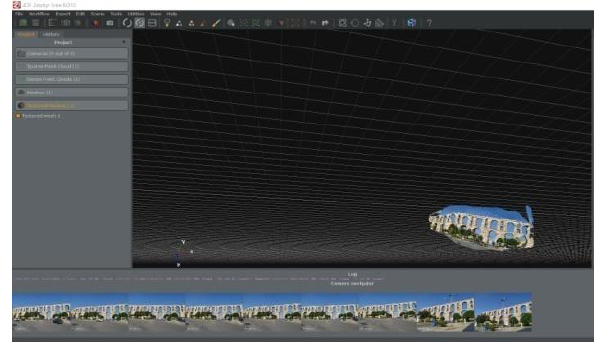
Figure 9 . The 3D Model of Front Side